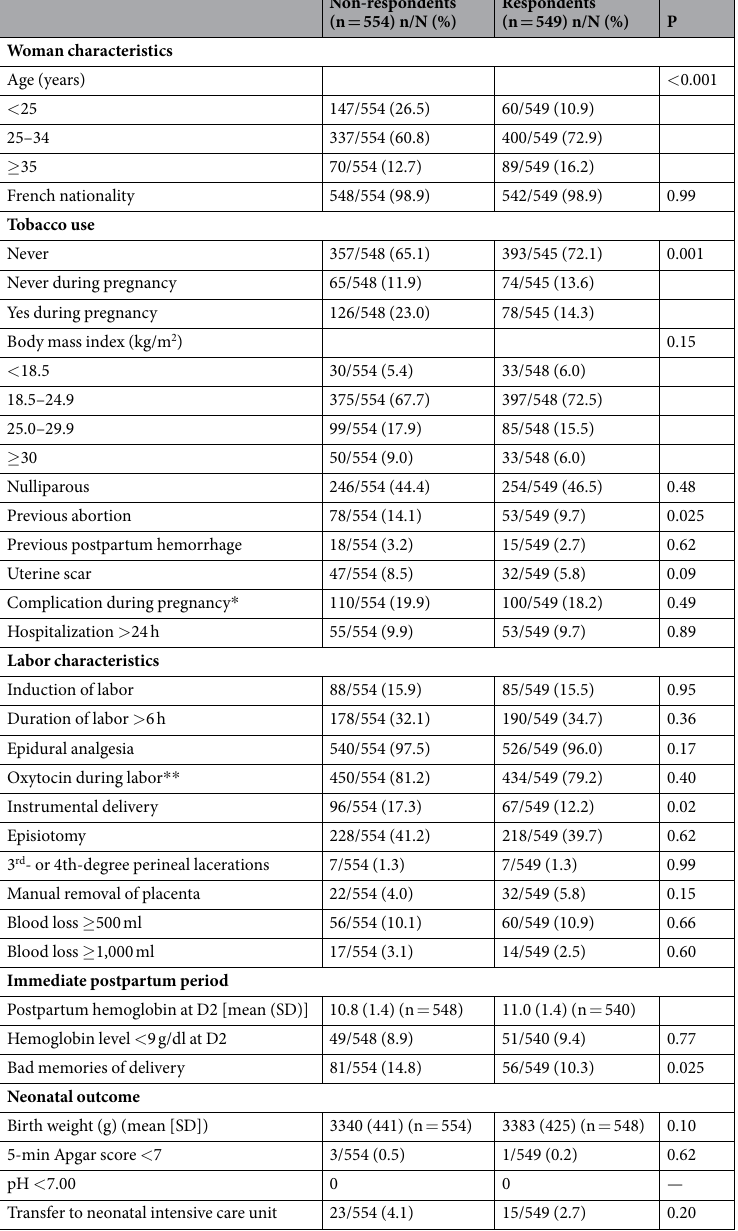
Table 1. Characteristics of woman, labor, delivery, immediate postpartum period, and neonates among respondents and non-respondents. * Complication during pregnancy including thrombocytopenia, gestational diabetes, bleeding, hypertension disorders, preterm labor. ** First and second